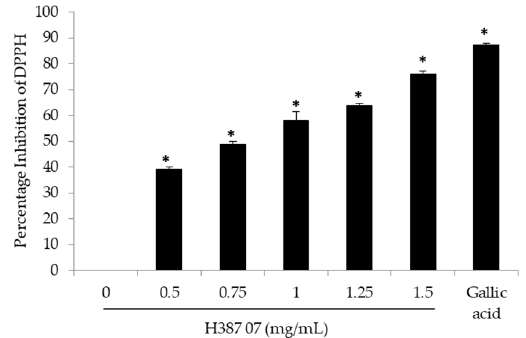
Figure 3. Inhibition of 2,2-diphenyl-L-picrylhydrazyl (DPPH) activity by extract H387 07. The average of three independent experiments ± standard deviation, * Significant difference (Tukey p <0.05).